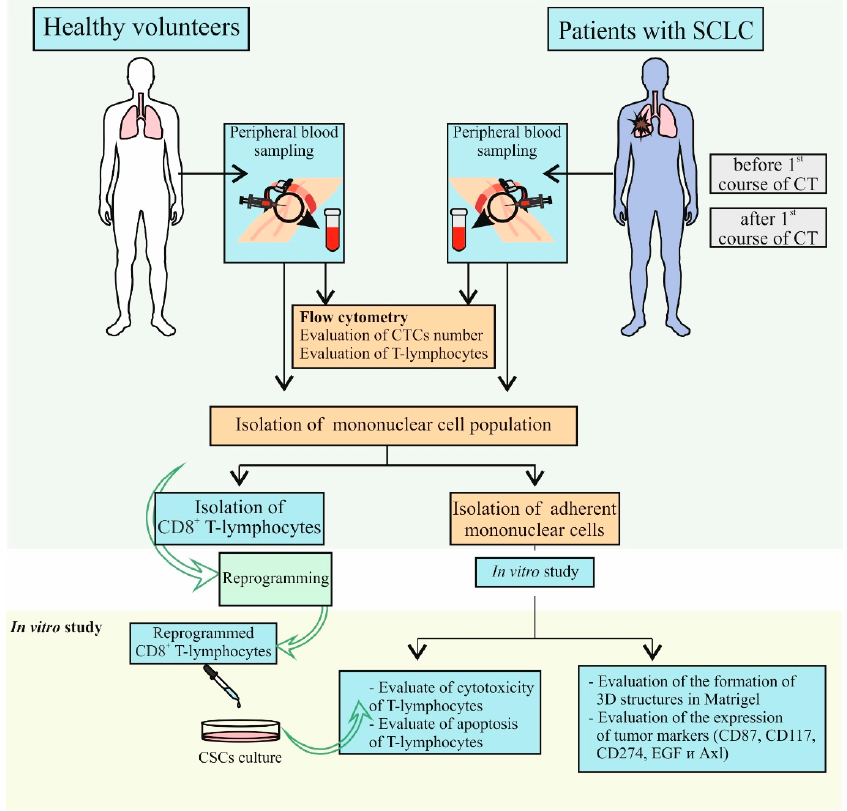
Figure 18. The experimental design. CT—chemotherapy, SCLC—small cell lung cancer.